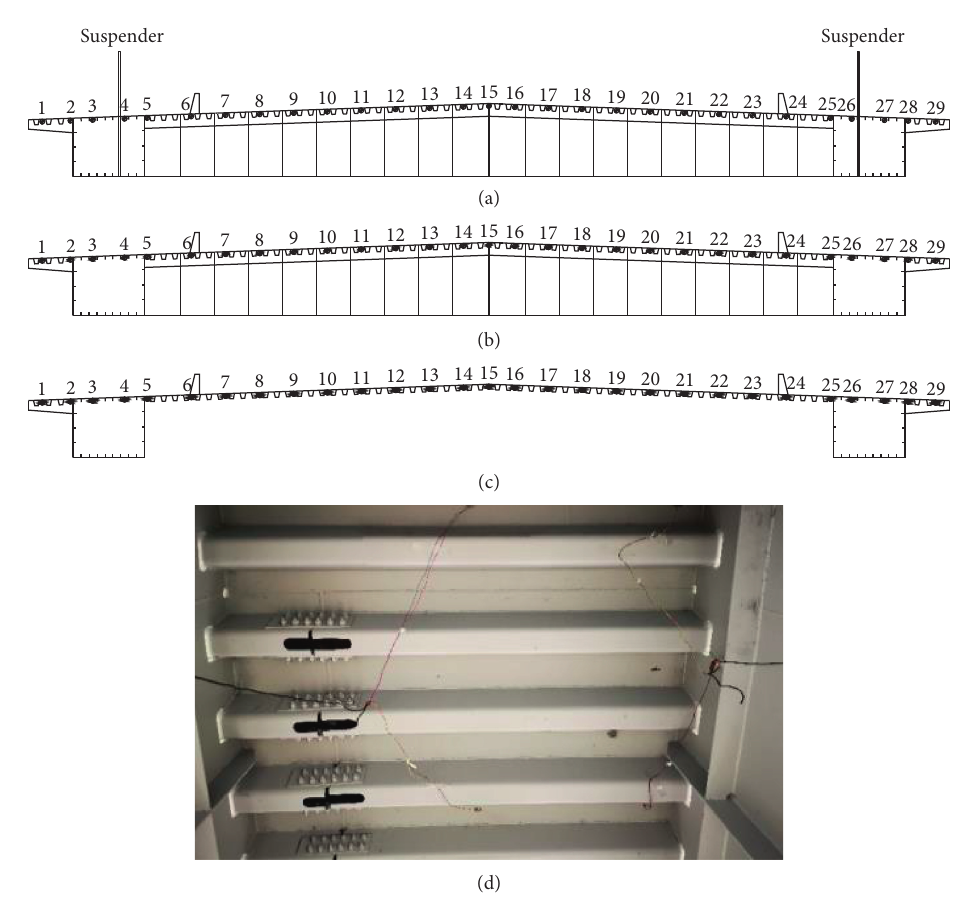
Figure 6: Selected cross sections and layout of measuring points. (a) Section 1-1. (b) Section 2-2. (c) Section 3-3. (d) Stress measuring points.